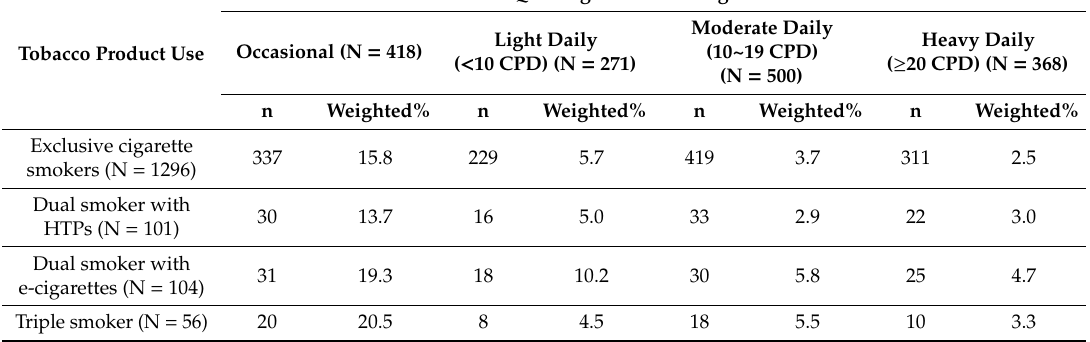
Table A1. Number and weighted percentage of intention to quit cigarette smoking according to tobacco product use and cigarette-smoking